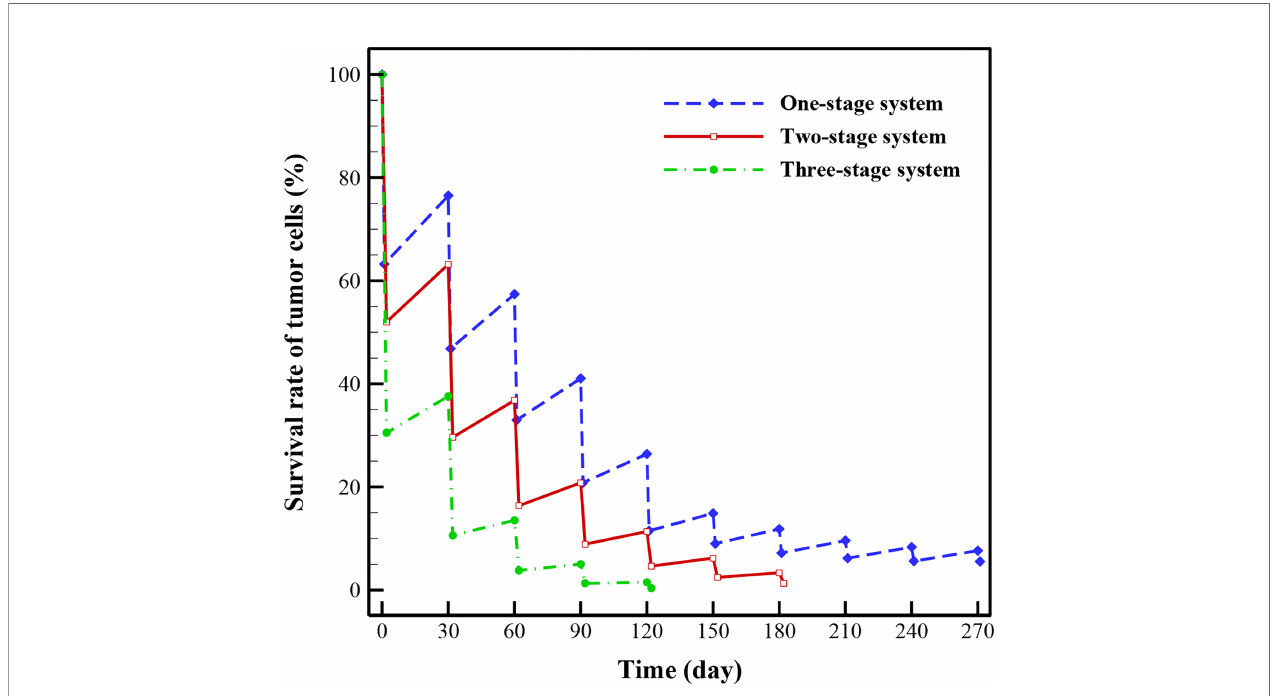
FIGURE 10 | Survival rate of TCs for one (conventional), two and three-stage drug delivery